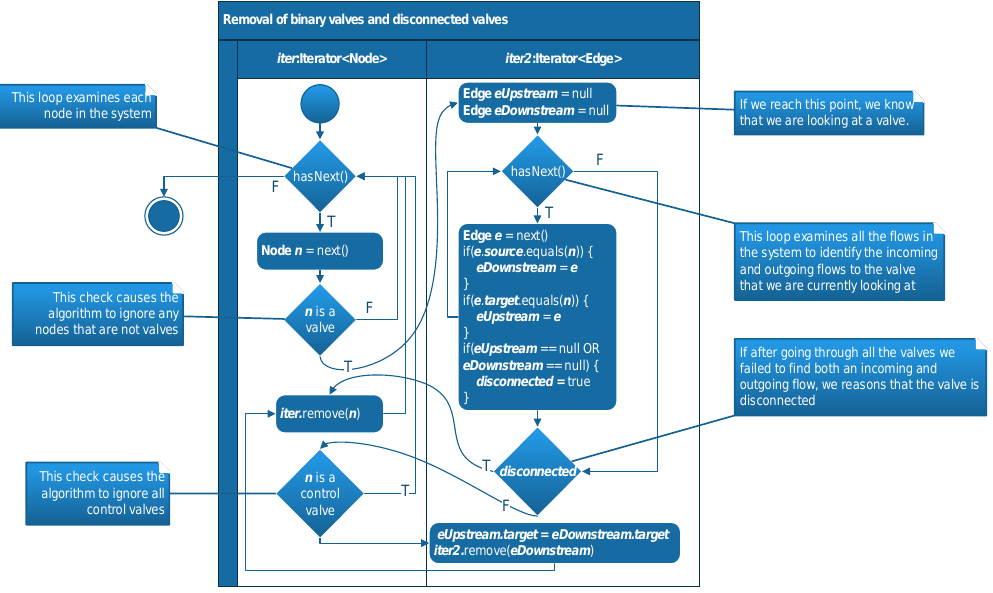
Figure 3. UML activity diagram represenation of an algorithm that removes binary valves from the intermediate graph representation of a process.